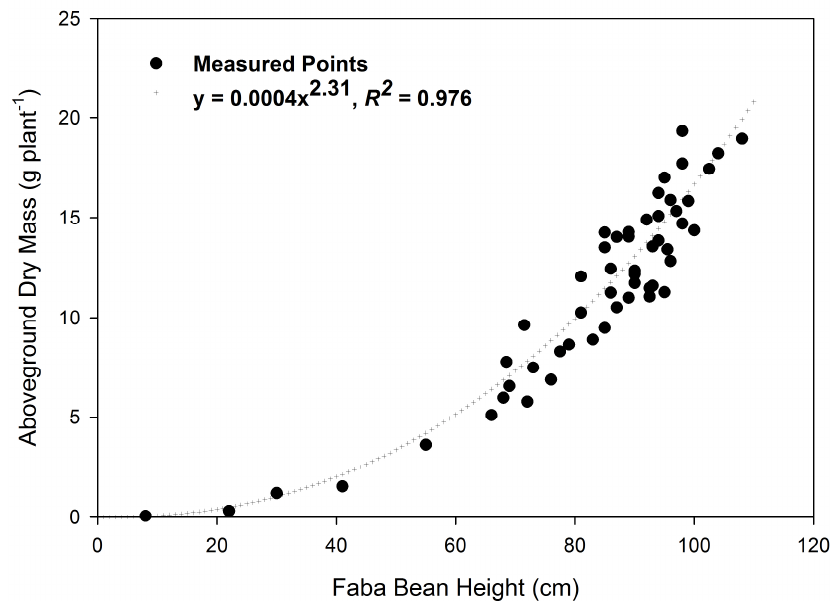
Figure 2. Allometric growth of faba beans. Shows the relationship between the average height of faba bean plants and dry aboveground biomass. Data obtained for >60 cm heights were taken from the dry weight of the aboveground biomass of all pots after completion of the second phases. Faba bean plants were grown during the first cropping phase in separate pots within the same greenhouse and were used to provide heights and dry weights in <60 cm heights. The trend line is modeled based upon the best coefficient of determination ( R 2